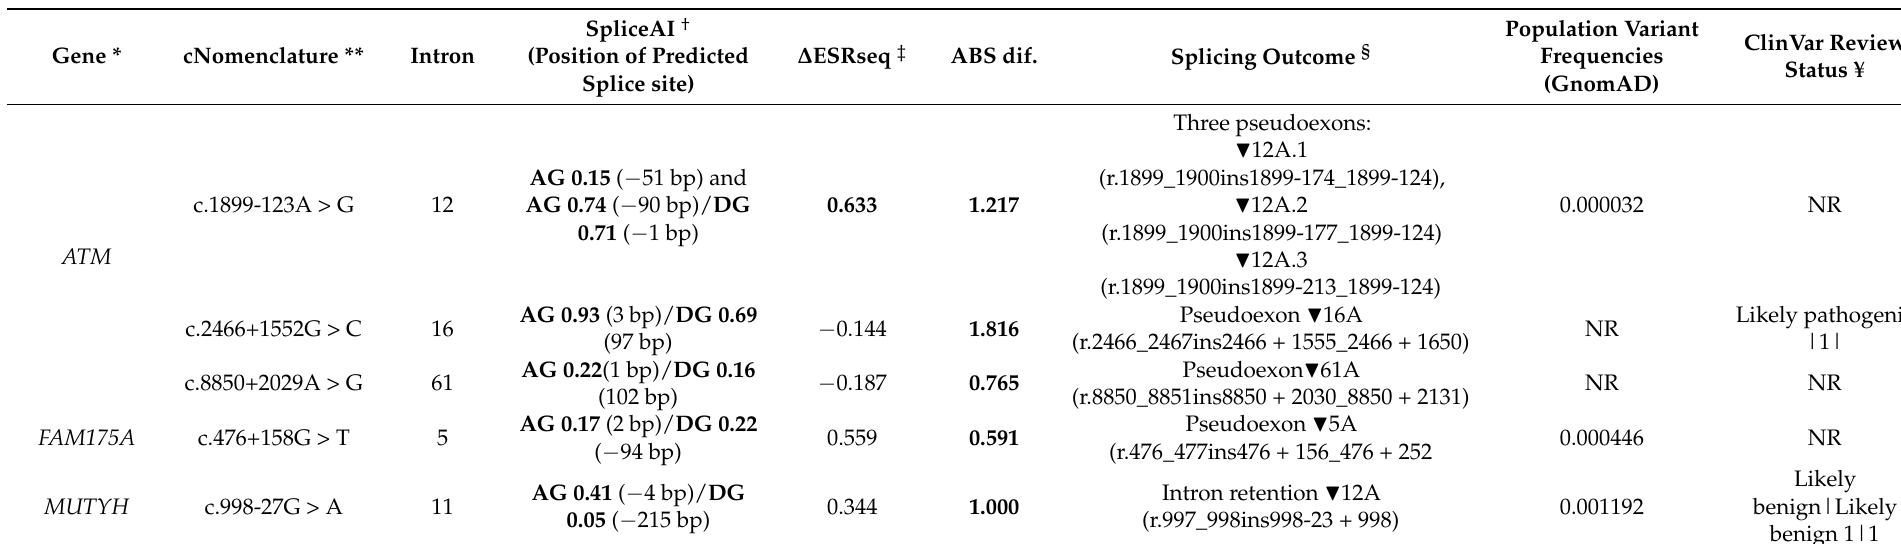
Table 3. Deep intronic variants with a spliceogenic effect detected in hereditary cancer